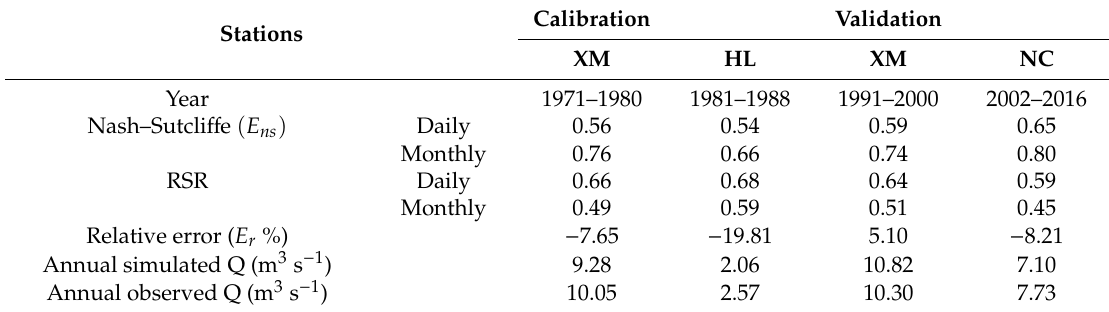
Table 3. Statistics of Distributed Hydrology Soil Vegetation Model (DHSVM) calibration and validation.